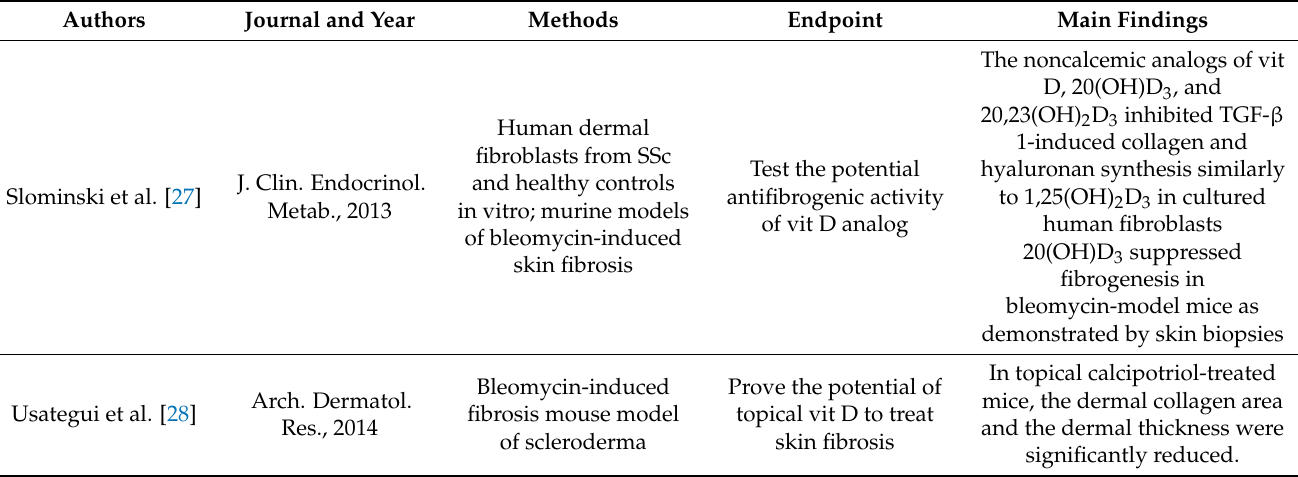
Table 1. Summary of the pre ‐ clinical study selected. Abbreviations: vit D, vitamin D; SSc, systemic sclerosis; VDR, vitamin D receptors; k/o, knock out; TGF, transforming growth factor; Th, T helper; Treg, regulatory T cells; IL, interleukin; ROR γ , Retinoic ‐ acid ‐ receptor ‐ related orphan nuclear receptor gamma; HOCl, hypochlorous acid; MMP, metalloproteinase; TIMP, tissue inhibitor of